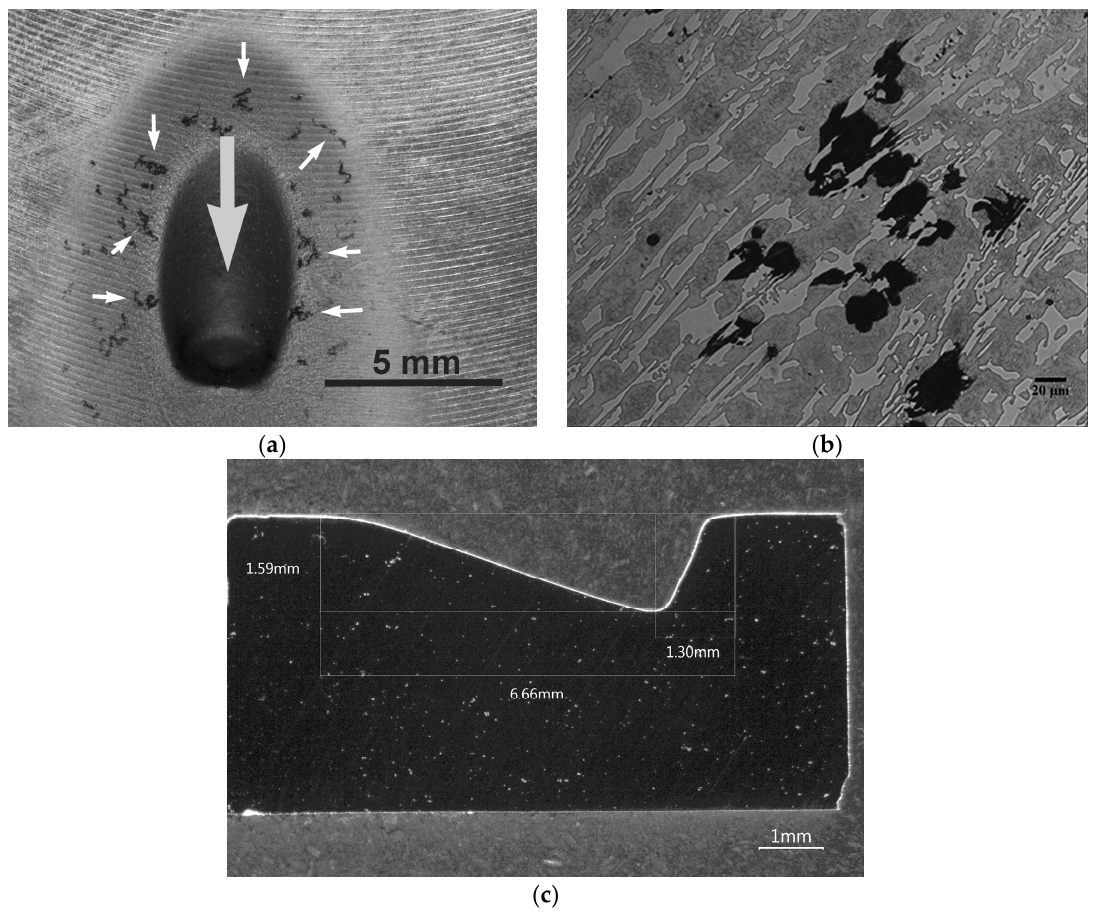
Figure 7. Morphology of the wear track. A track obtained from one of the specimens corresponding to Experiment 5: ( a ) The light grey arrow indicates the direction of impact of the corundum jet. The white arrows point to different impact marks of corundum particles around the wear track; ( b ) The impact of corundum particles produces deterioration of the matrix constituent without initially affecting the eutectic carbides. Once the deterioration of the matrix constituent surrounding these carbides occurs, they are released. ( c ) Profile of the wear track.